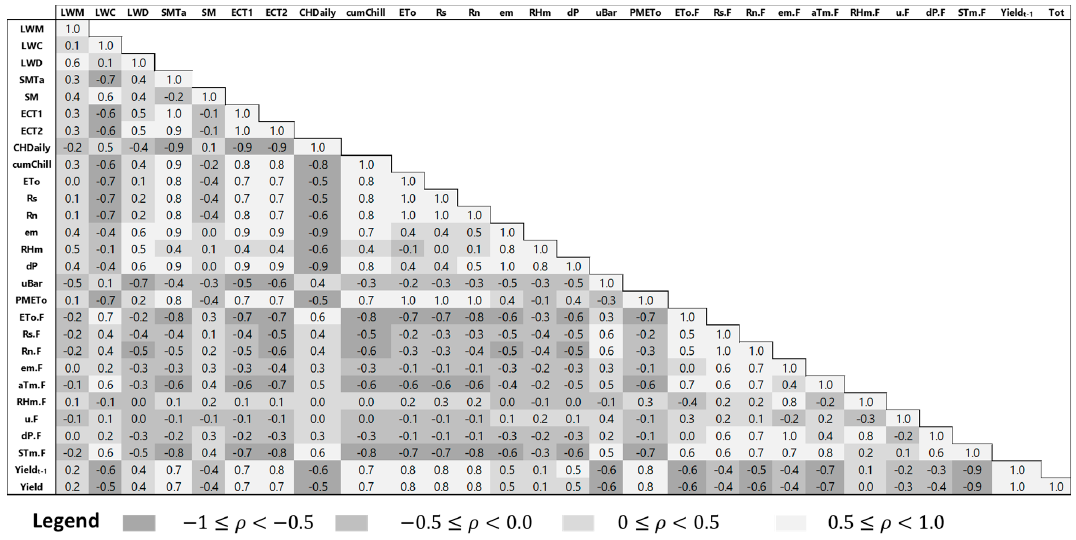
Figure 4. A matrix of correlation among the input parameters as well as the response variable.